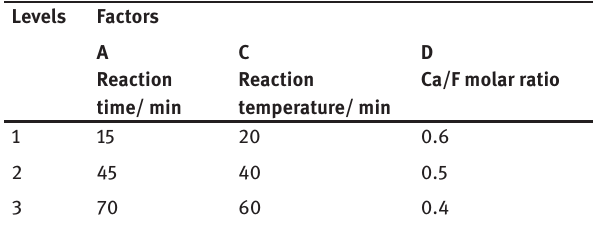
Table 2: Factors and levels of orthogonal text.